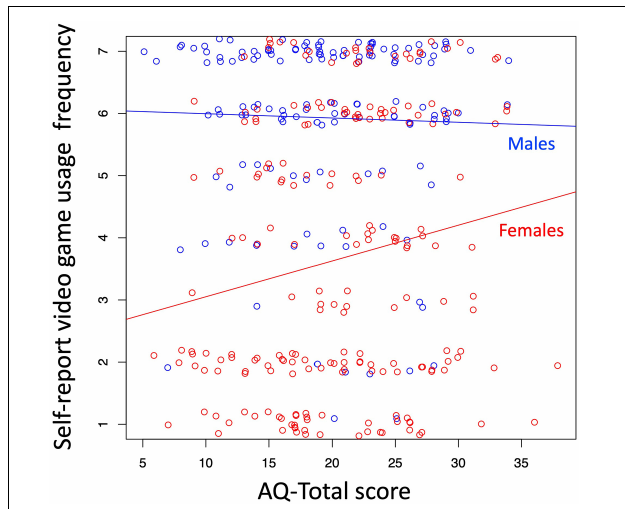
FIGURE 1 | Relationship between self-reported frequency and AQ scores for females (red) and males